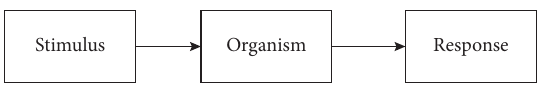
Figure 1: Stimulus organism response